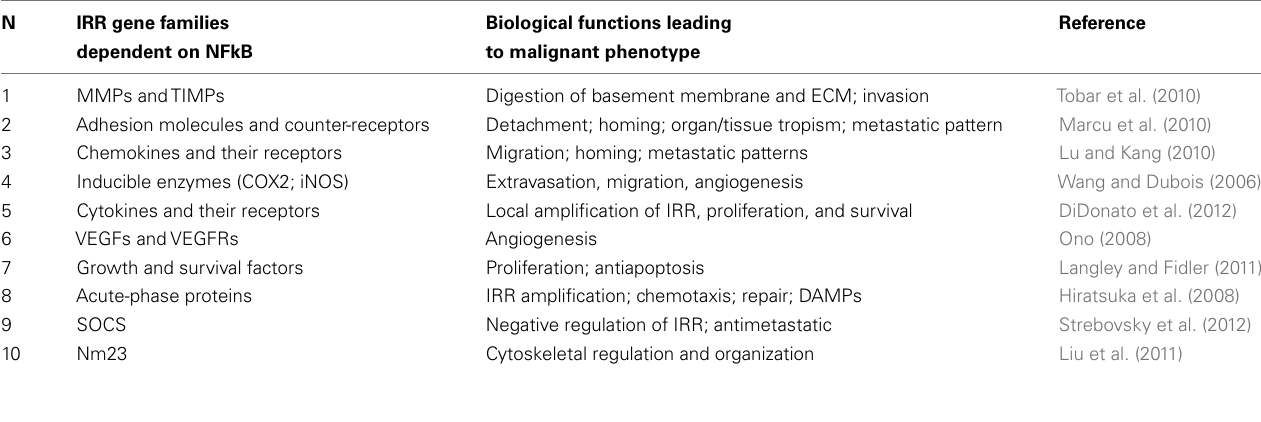
Table 2 | IRR gene expression and malignant phenotype biological